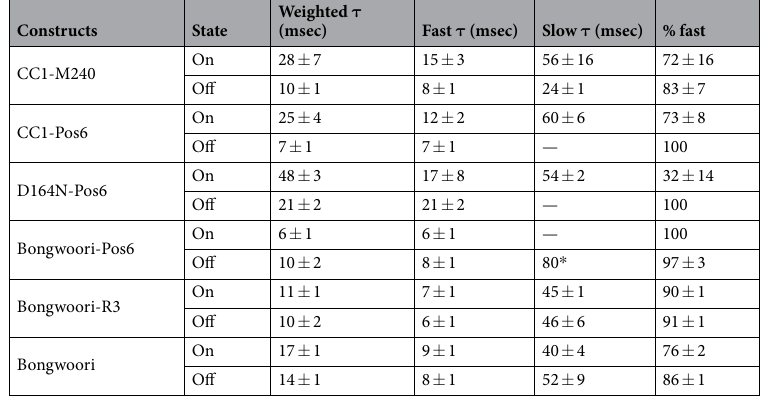
Table 2. Kinetics of GEVIs tested in HEK 293 cells. Values are shown as the mean ± SEM (standard error of the mean). The number of cells analyzed; CC1-M240: 4, CC1-Pos6: 6, D164N-Pos6: 6, Bongwoori-Pos6: 4, Bongwoori-R3: 5, Bongwoori: 4. * Only one cell showed slow component for tau off at a 100 mV